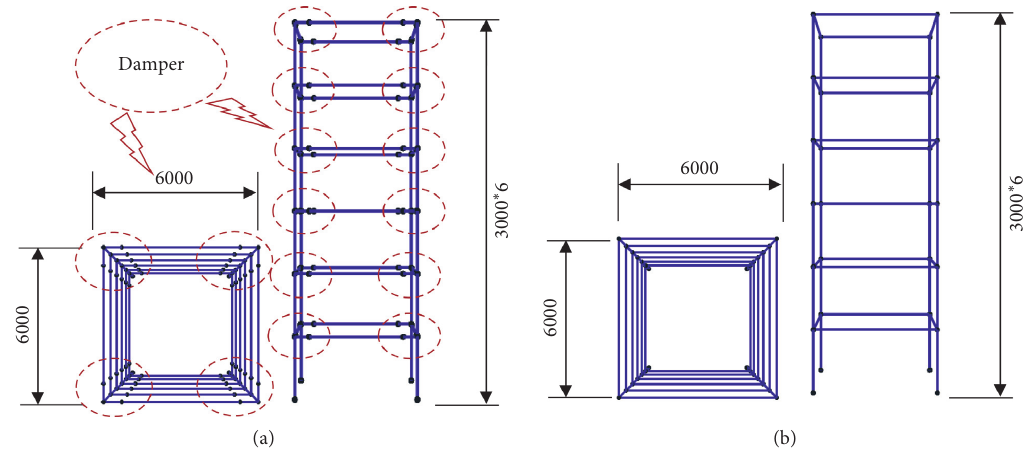
Figure 14: Controlled structure model (mm). (a) Controlled structure. (b) Uncontrolled